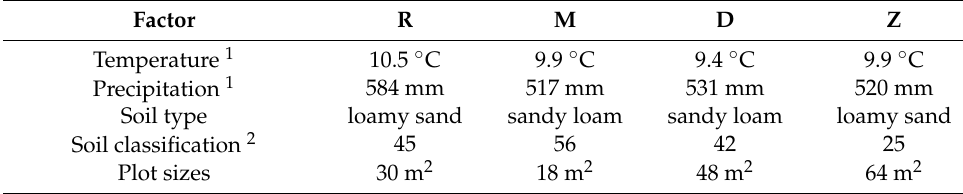
Table 1. Field conditions at the experimental sites.